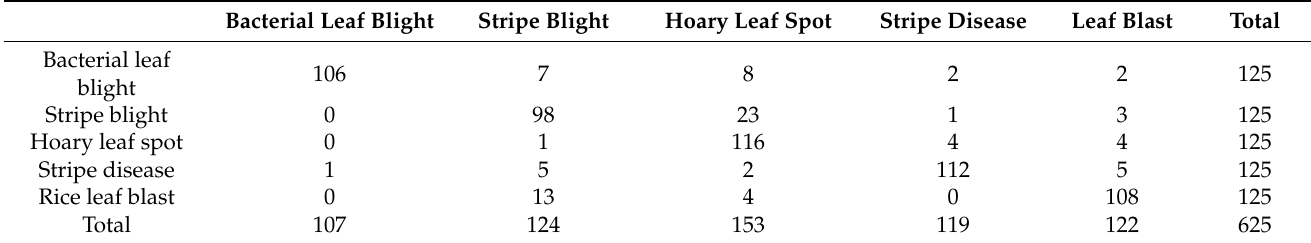
Table 4. Confusion matrix of GoogLeNet network model.